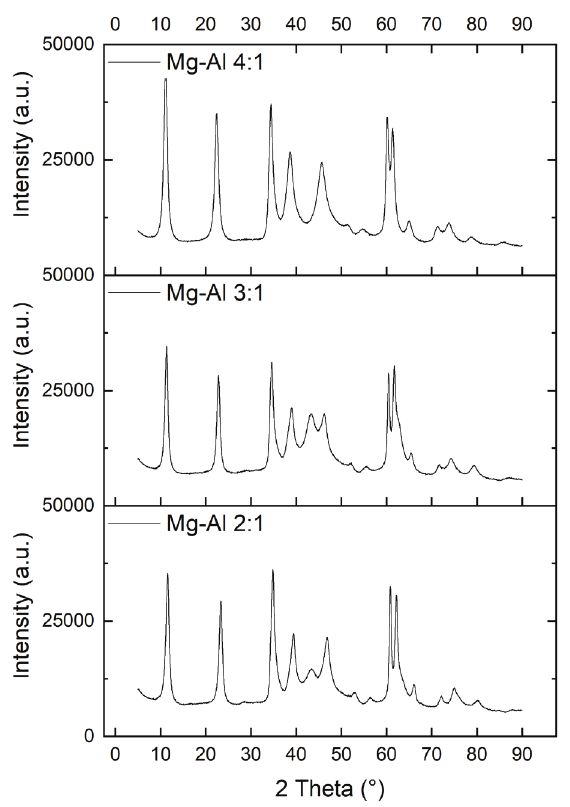
Fig. 1 – X-ray diffractogram of prepared Mg-Al materials